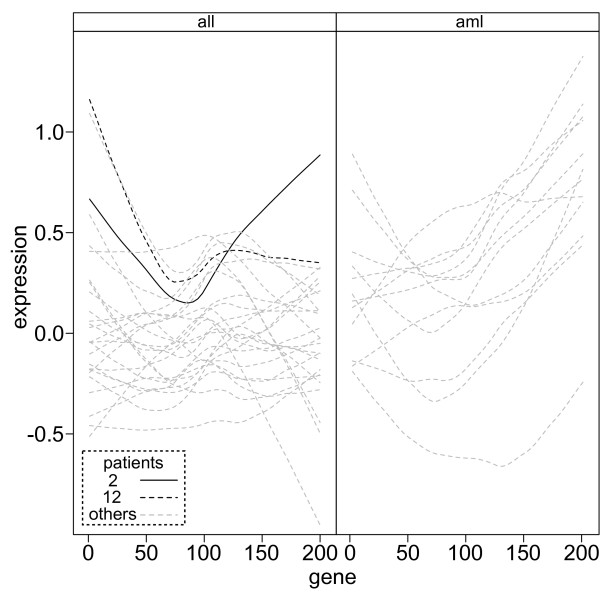
Leukaemia patient expression profiles. The expression profiles of all leukaemia patients were plotted against the gene identification number grouped by patient class ('all' and 'aml' panels) and the profiles of atypical all profiles for patients 2 (solid black line) and 12 (dashed black line) highlighted.